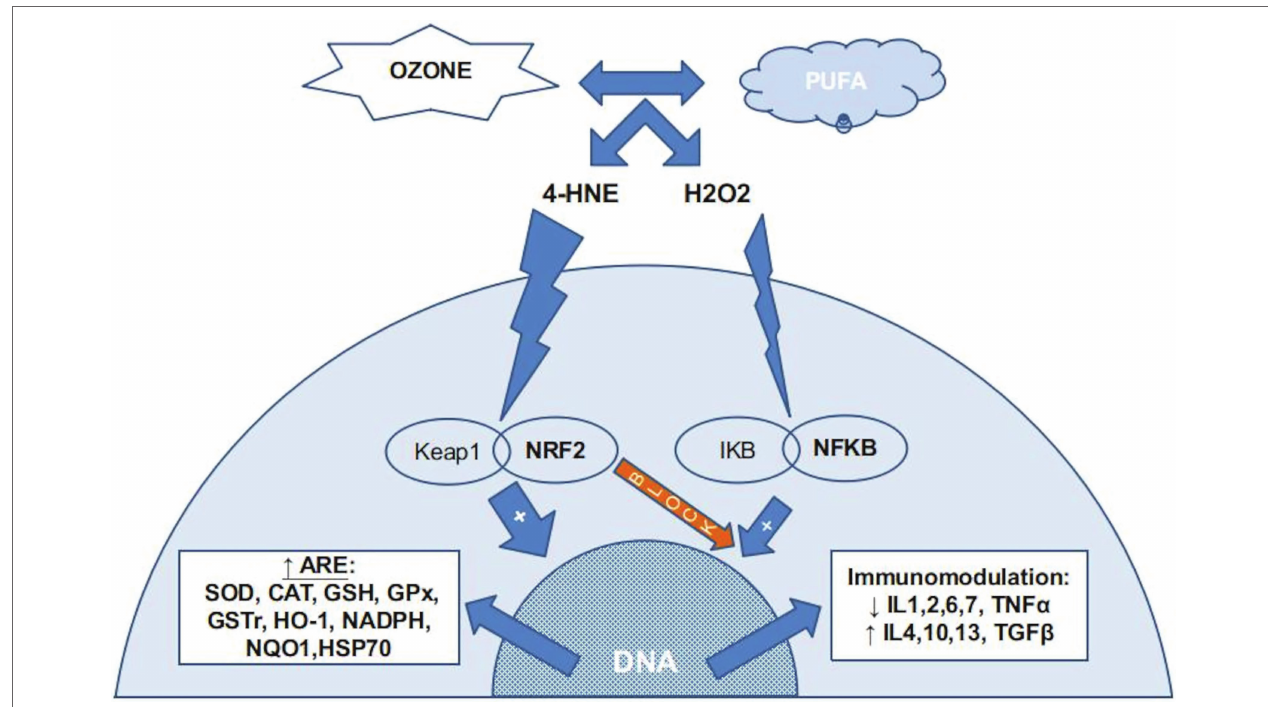
FIGURE 1 | The chemical reaction between ozone and PUFA (poli-unsaturated fatty acids) in the insterstitial water (or plasma) produce several ROS, mainly H 2 O 2 , and several LOPs, mainly 4-HNE (4-hydroxynonenal). Almost all H 2 O 2 is kidnaped by erythrocytes (not reflected in this figure) if present. In nucleated cells, LOPs activates the NRF2 pathway, inducing the production of ARE (antioxidant response elements) and blocking the NFKB pathway. A small amount of H 2 O 2 stimulates the NFKB pahtway, usually balanced with the NRF2 blocking action, producing a